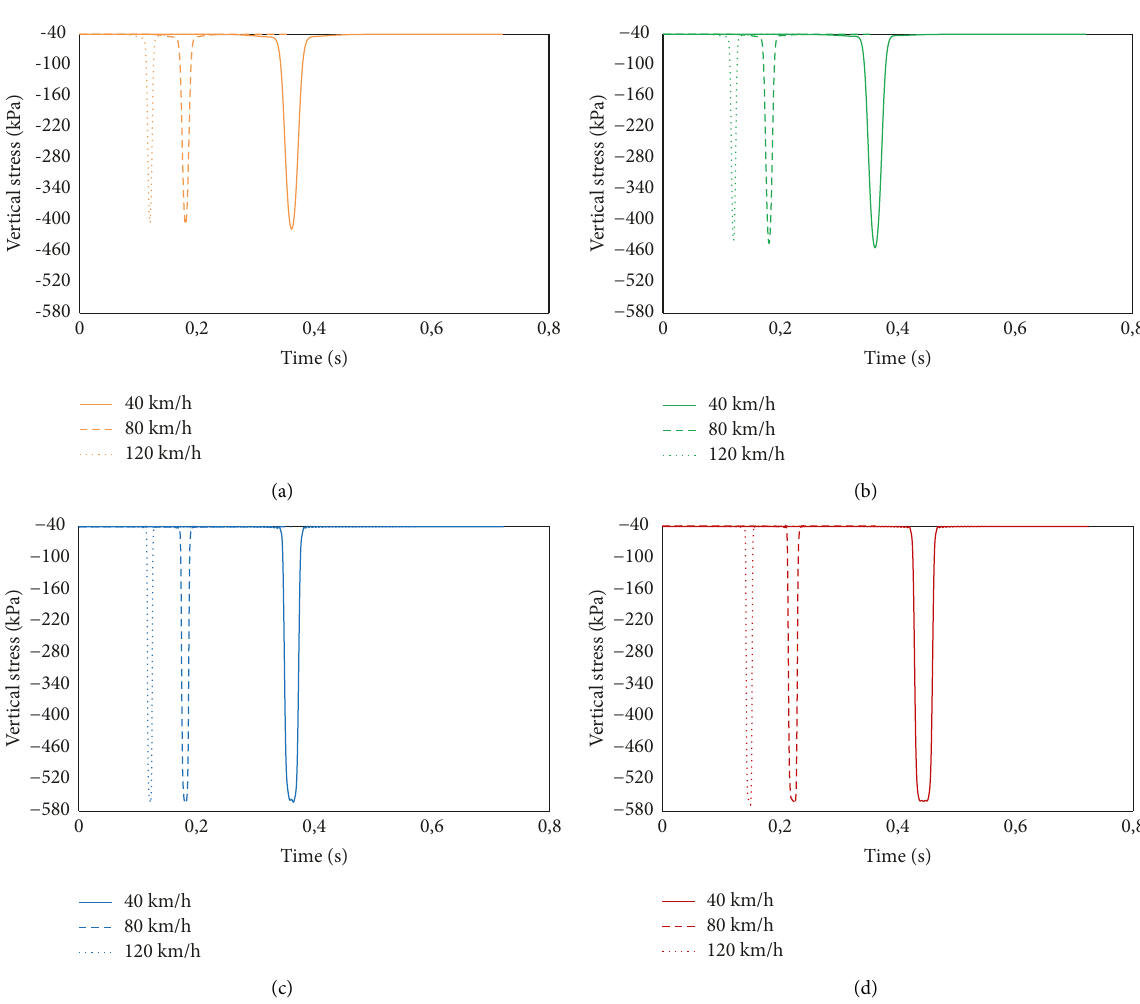
Figure 5: Influence of load speed on vertical stress. Base layer (a) RAP_3E2C; (b) RAP_3F2C; (c) RAP_2F1H; (d) GCS_2F1H.